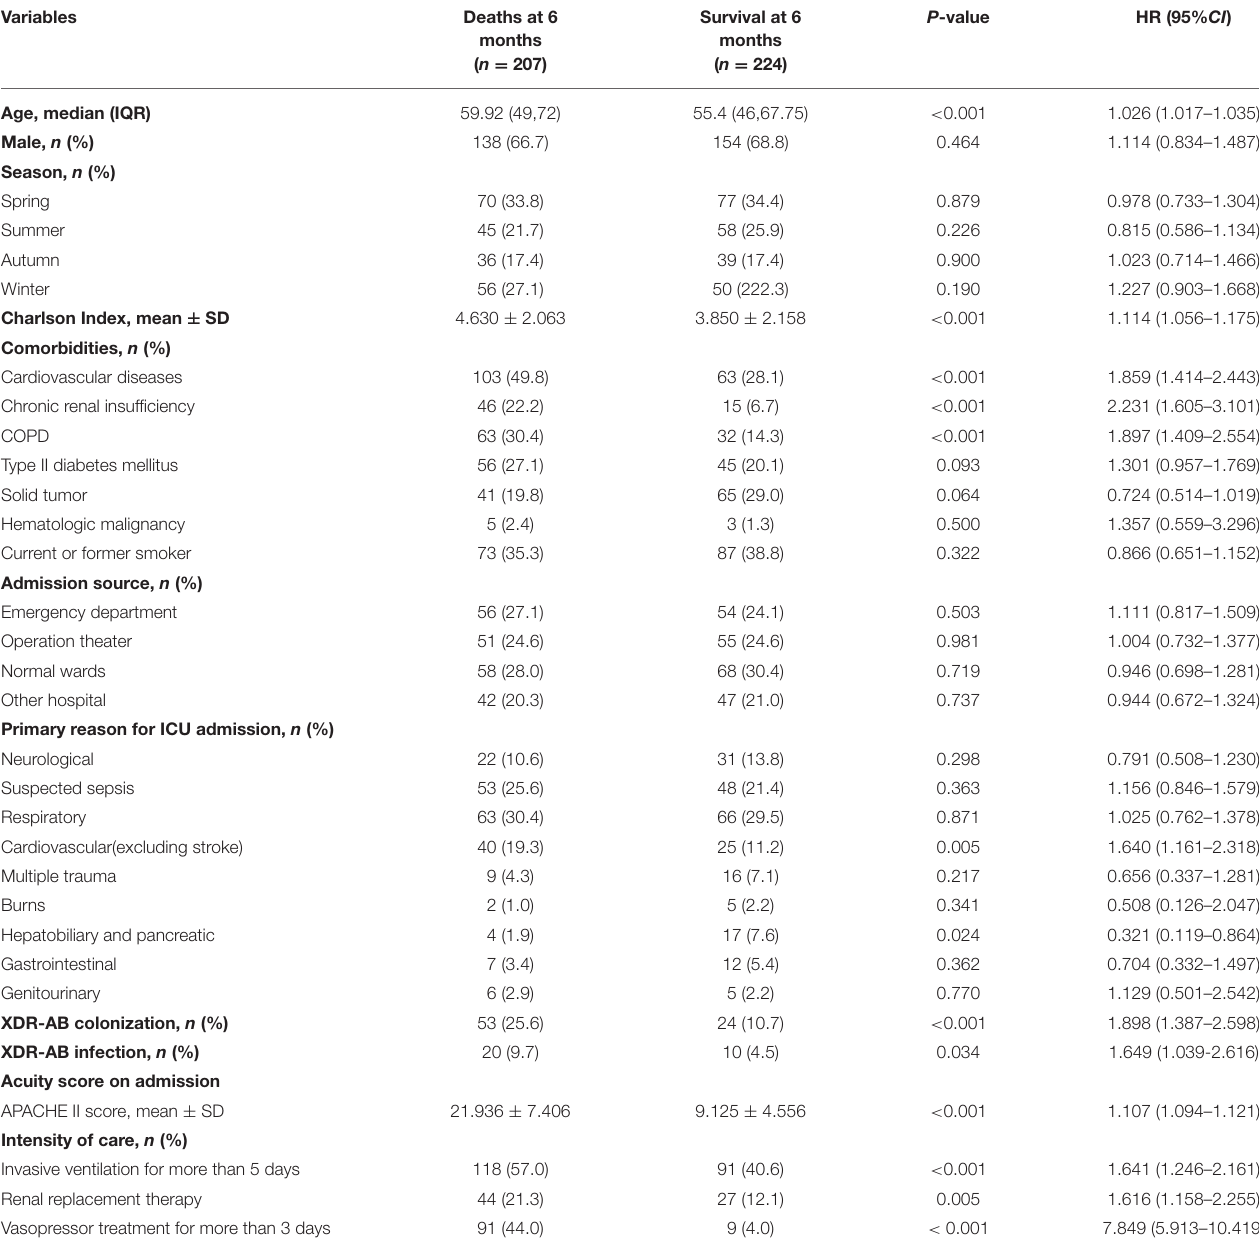
TABLE 4 | Univariate Analysis of Factors Associated with mortality in 6 months.